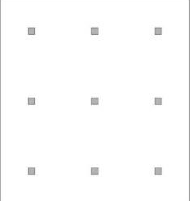
Figure 10. Cropped location of aerial photographs